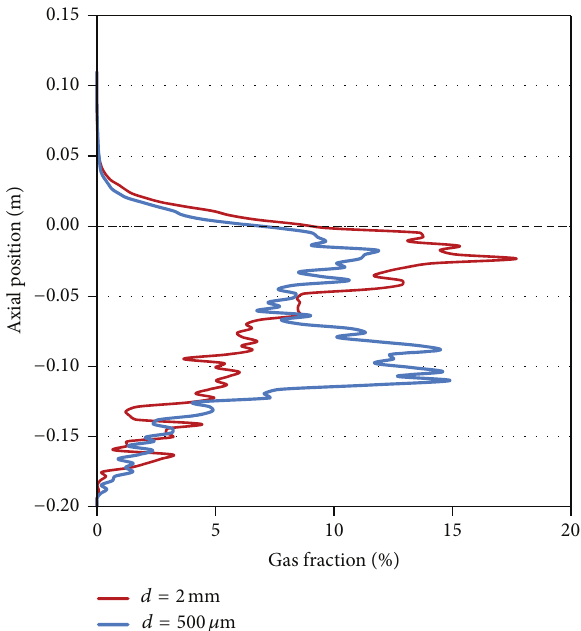
Figure 6: Axial plot of gas fraction along the jet centerline. Dashed line shows the location of the initial liquid surface.